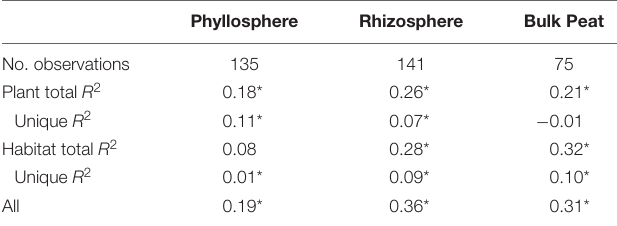
TABLE 3 | Variance partitioning of putative methanotrophs by compartment based on Bray–Curtis distance between communities considering each compartment (phyllosphere, rhizosphere, and bulk peat)